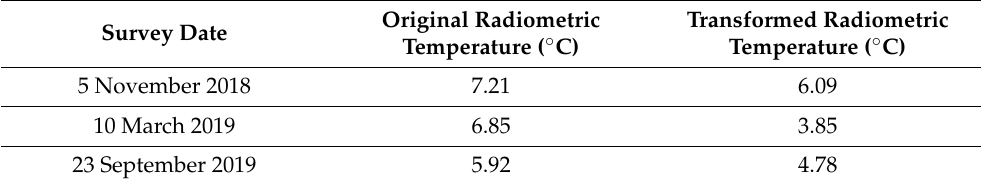
Table 4. RMSE values for original radiometric temperature and transformed radiometric tempera- ture